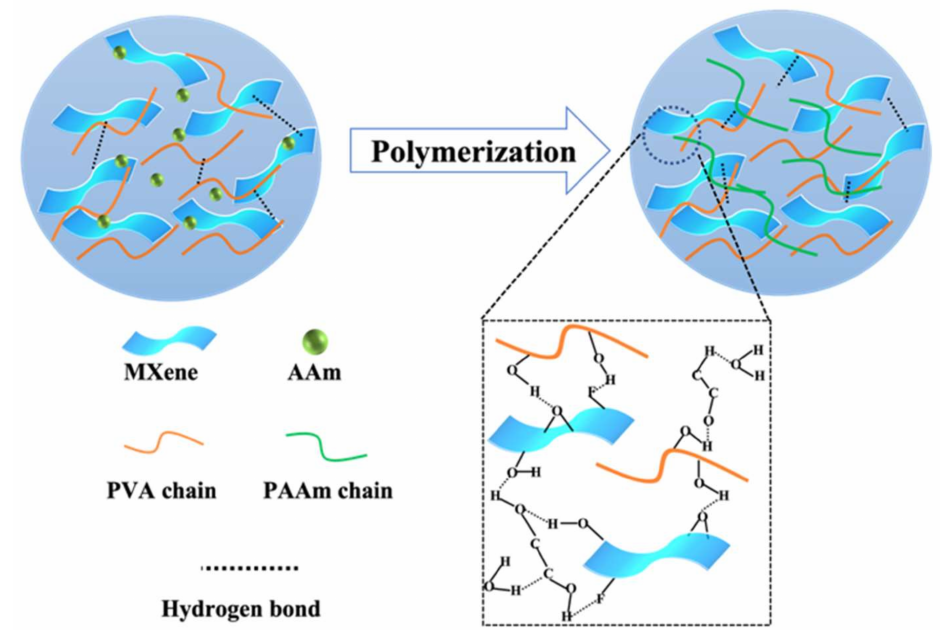
Figure 3. Schematic illustration of the fabrication and interaction of PAEM hydrogels and their gel